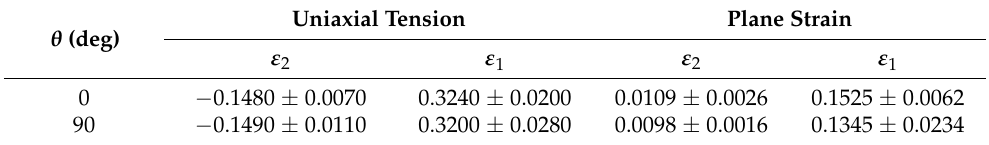
( f ) Figure 11. SEM micrographs (1500×) and corresponding binarized image of CR980XG3 TM steel sheet in ( a , b ) as received, ( c , d ) 13% true strain, and ( e , f ) fractured condition.